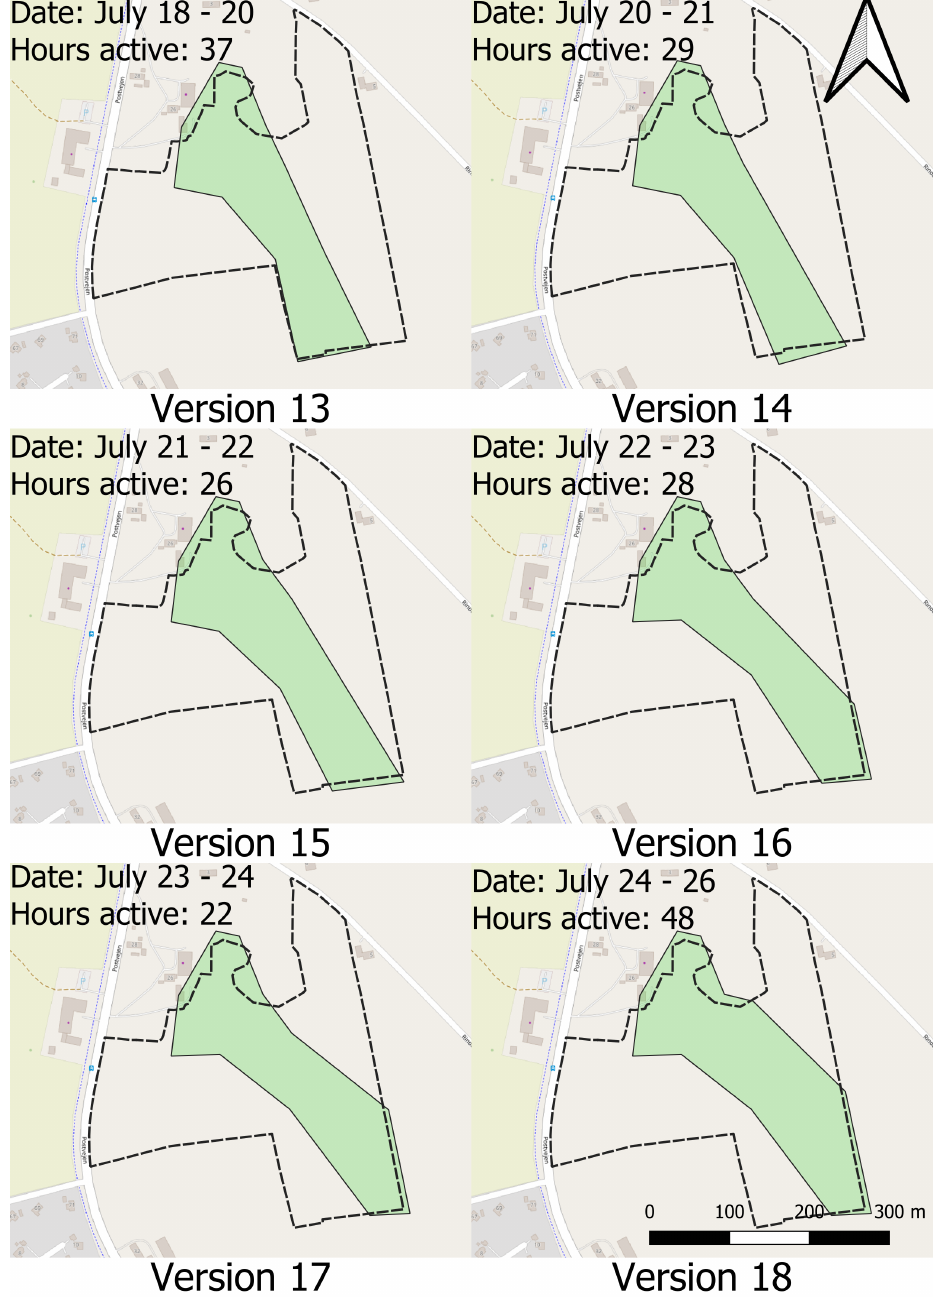
Figure A3. Virtual enclosure version 3 dating from 18 July to 26 July. The dashed black line represents the physical fence surrounding the 8.2 ha grazing area. The marked green area represents the virtual enclosure. Only virtual enclosures active for more than 12 h were included. The coordinates of the up- per left corner of the map frame are 55°25 (cid:48) 23.131 (cid:48)(cid:48) E 8°23 (cid:48) 53.531 (cid:48)(cid:48) N. Map data from OpenStreetMaps